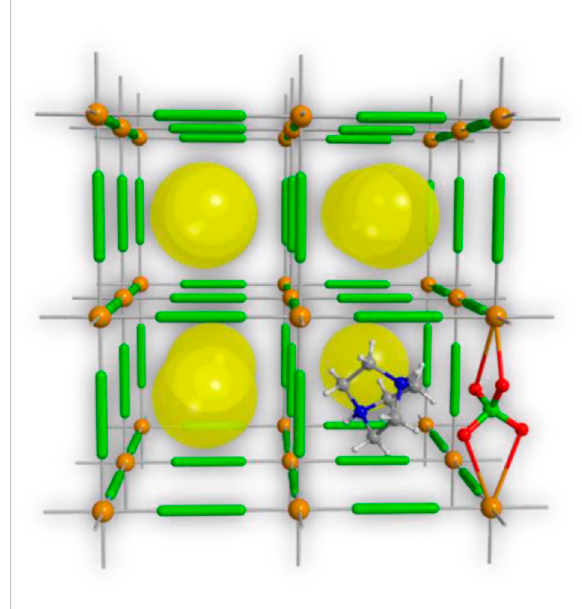
FIGURE 12 Schematic diagram of molecular perovskite-type energetic material structure (Chen et al.,